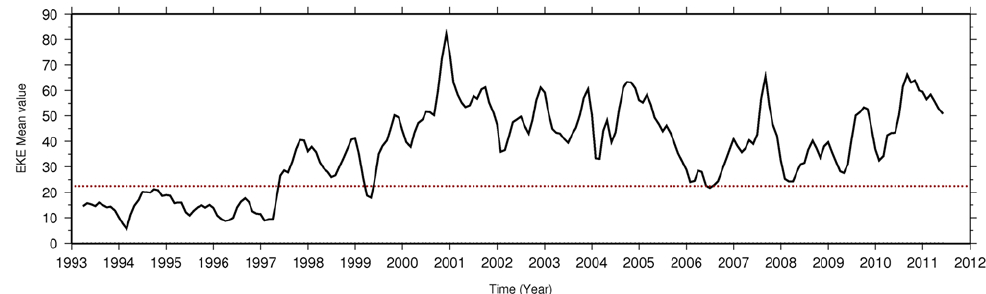
Fig. 15. Time series of mean LF-EKE in boxes E1 + E2 + E3 + E4 + E5 as defined in Fig. 14 during the period 1993–2011. Units in cm 2 s − 2 .